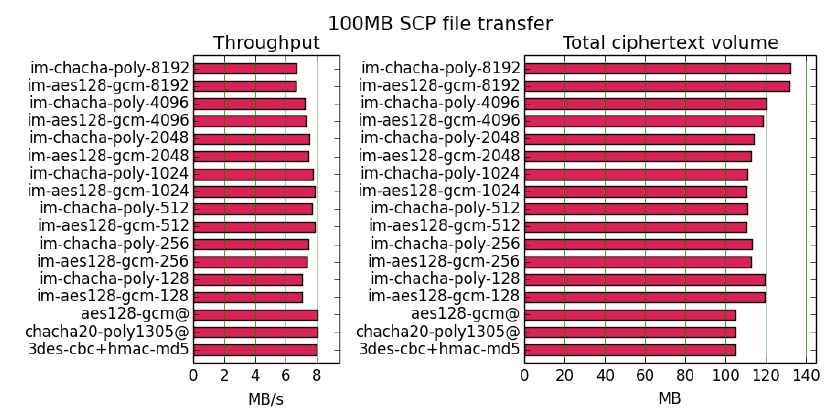
Figure 3: Measurements for InterMAC-based encryption schemes, OpenSSH AEAD-based encryption schemes and the OpenSSH AES-CBC encryption scheme using the OpenSSH version of the data copy tool SCP between two t2.nano AWS EC2 instances in two different regions. “im- Y - X ” denotes InterMAC-based scheme being used with Y as the internal nonce-based AE scheme, and with chunk length X bytes, @ is short-hand for @openssh. ( left chart ) Throughput in MB/s (higher is better); median over 100 samples for a 100MB file transfer for each encryption scheme. ( right chart ) Total volume of ciphertext bytes sent on the wire (lower is better); median over 100 samples for a 100MB file transfer for each encryption scheme.